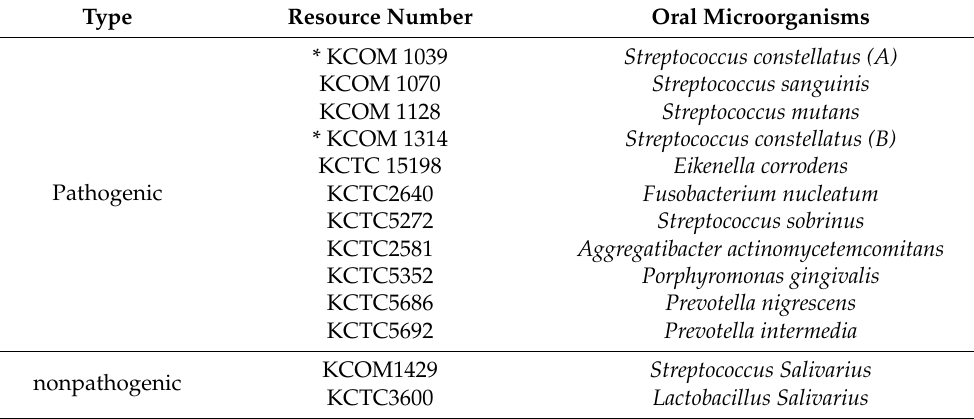
Table 1. Pathogenic and nonpathogenic oral bacteria. Eleven types of pathogenic oral bacteria used in antibacterial testing and two types of nonpathogenic oral bacteria used in antibacterial testing. * The sources of KCOM 1039 and KCOM 1314 were maxillary sinusitis and parotiditis, respectively.